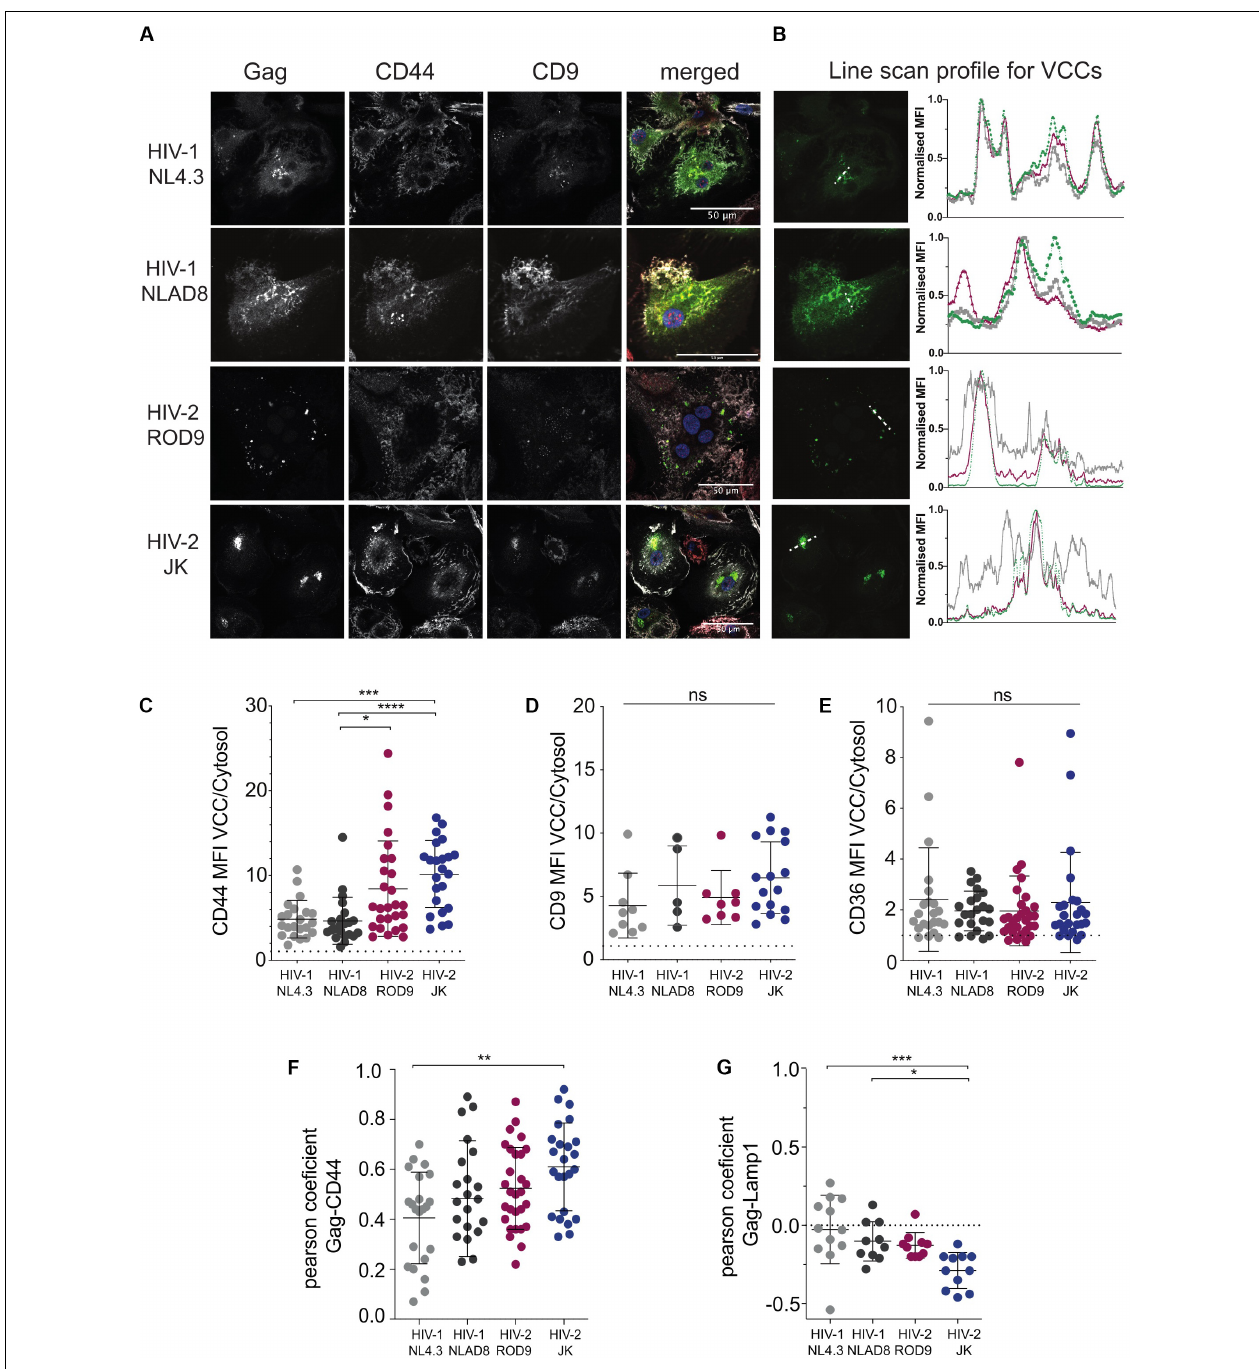
FIGURE 2 | HIV-2 Gag localizes in Virus-Containing Compartments in primary human MDMs. (A) MDMs were infected for 3 days with the indicated viruses, all VSV-G-pseudotyped. Samples were stained for the indicated markers by immunofluorescence. Representative confocal sections are presented from at least 6 donors. (B) Line intensities profiles for all the markers (A) . Profiles were performed on the white dotted lines shown on the Gag images. Intensities profiles were normalized to highest value for each marker. Green line corresponds to Gag, gray to CD44 and red to CD9. (C–E) Quantification of each marker enrichment in VCCs calculated as the ratio MFI present in VCCs over the one present in the cytosol on confocal sections. VCC and cytosol were segmented by masks on Gag and CD44 staining, respectively (see section “Materials and Methods”). (F) Analysis of the co-distribution between Gag and CD44 and (G) between Gag and Lamp1 on confocal sections by measurement of the Pearson coefficient. Each dot represents a cell. P -values were calculated using Kruskal–Wallis non-parametric test with Dunn’s correction for multiple comparison. P -values lower than 0.05 were considered as significant (* p < 0.05, ** p < 0.01, *** p < 0.001, **** p < 0.0001).